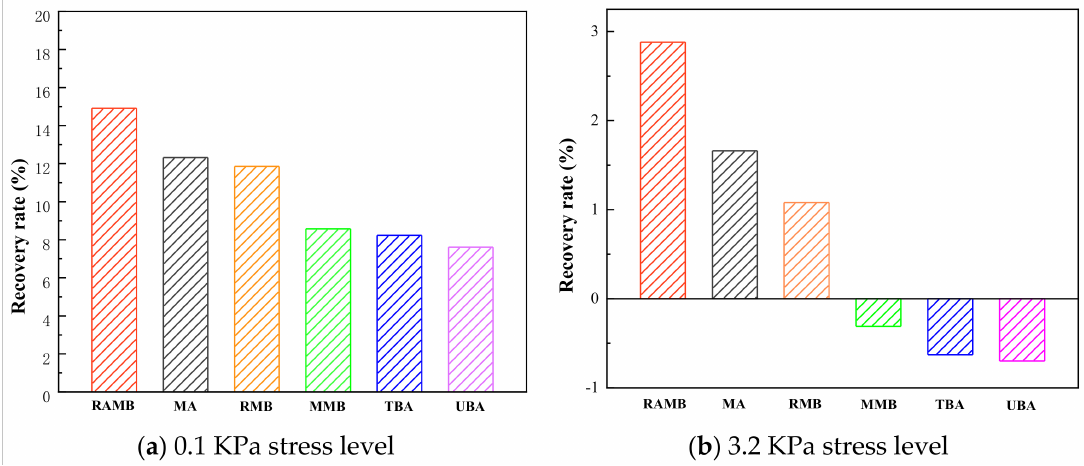
Figure 7. R value of different asphalts.